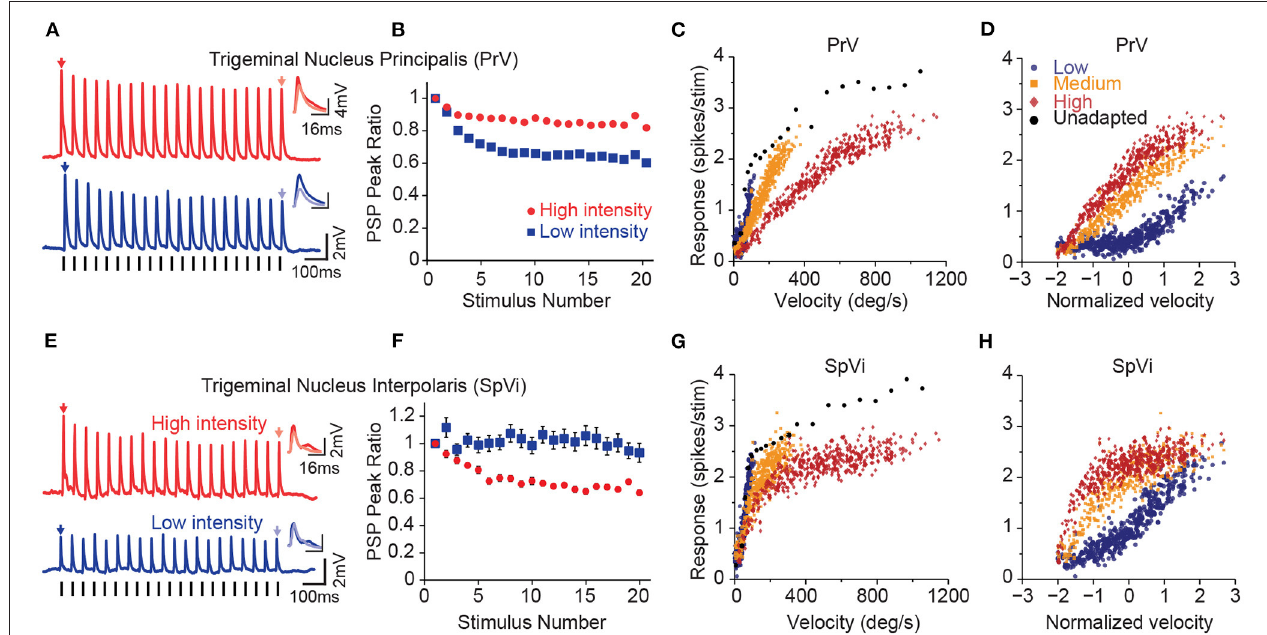
FIGURE 2 | Parallel processing of tactile intensity during adaptation in the two trigeminal nuclei. (A) Sub-threshold post-synaptic responses of a PrV neuron to repeated low intensity input (blue) and high intensity stimulation (red). (B) Normalised peak sub-threshold response of PrV neurons for two intensities. PrV neurons exhibit less adaptation to the stronger stimulation. Error bars represent s.e.m. (C) Population averaged firing responses of PrV neurons as a function of stimulation velocity at low (blue circles), medium (orange squares), and high (red diamonds) intensity contexts. (D) Same data as in (C) , but re-plotted as a function of normalised (Z-scores) velocity. (E) Sub-threshold post-synaptic responses of a SpVi neuron to repeated high and low intensity stimulation. (F) Normalised peak sub-threshold response of PrV neurons for low and high intensities. In contrast to PrV, SpVi neurons adapt more to higher intensity stimulation. Error bars represent s.e.m. (G) Average firing response of SpVi neurons as a function of stimulation velocity. (H) as in (G) , but as a function of normalised (z-scored) velocity. Although unadapted responses (black circles) are similar for both nuclei, PrV encodes stimulus intensity more linearly at the high-intensity context and the SpVi better encodes the low-intensity context. Modified from Ganmor et al. (2010), Mohar et al. (2013), and Mohar et al.